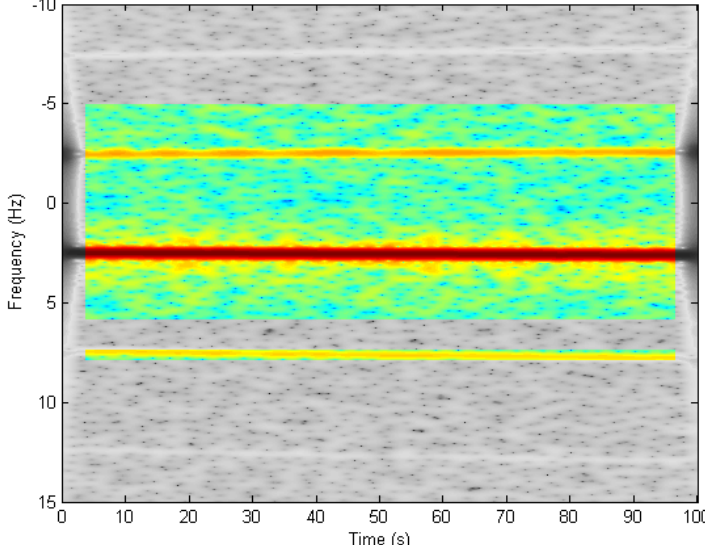
Figure 7. Example of t-f spectrum where the range of frequencies that would be necessary to obtain broken bar fault features has been